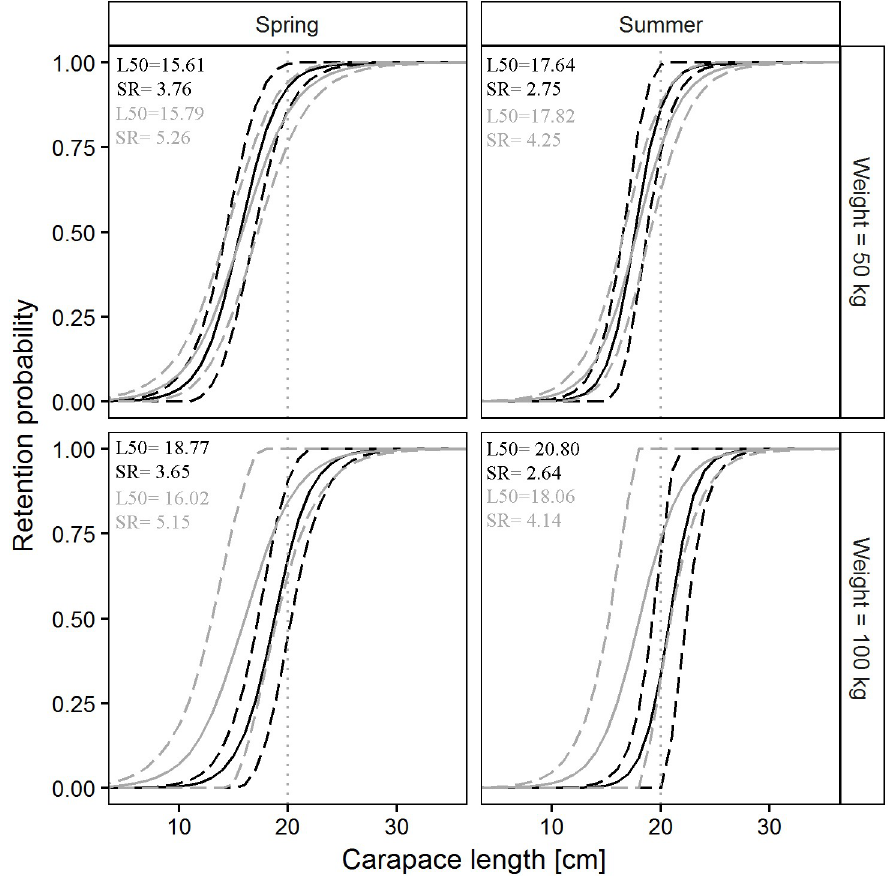
Fig 9. Differences in deep-water rose shrimp retention probability between the SM40 (black) and the DM50 (grey) codend in four simulated scenarios. Dashed lines: 95% CI for the mean curve (solid line); dotted vertical line: MCRS for deep-water rose shrimp (CL, 20